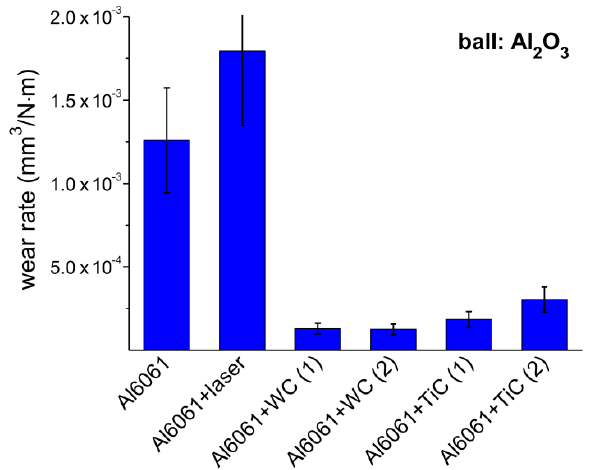
Figure 10. Wear rates calculated from the volume loss vs. sliding distance dependencies shown in Figure 9.